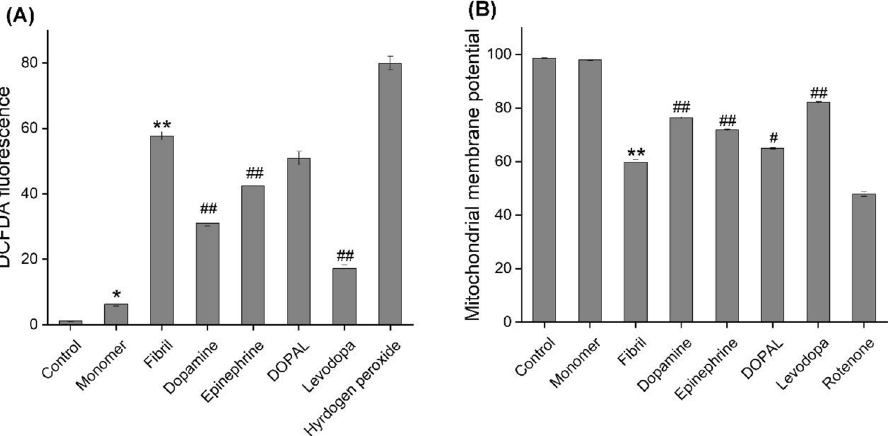
Figure 6. The effect of catechols on the α-syn aggregates-induced intracellular ROS and mitochondrial membrane potential in SH-SY5Y cell evaluated by flow cytometry. ( A ) and ( B ) Plots of the fluorescence intensities of DCFDA and Rhodamine 123 probes in cells exposed to 20 µM α-syn aggregates, produced in the absence or presence of 200 µM catechols, respectively. The effect of hydrogen peroxide and rotenone on intracellular ROS content and mitochondrial membrane potential, respectively, are also indicated. * p < 0.05, ** p < 0.01 significantly different from control cells. Data are expressed as mean ± SD with n = 3. # p < 0.05, ## p < 0.01 significantly different from cells exposed only to α-syn amyloid